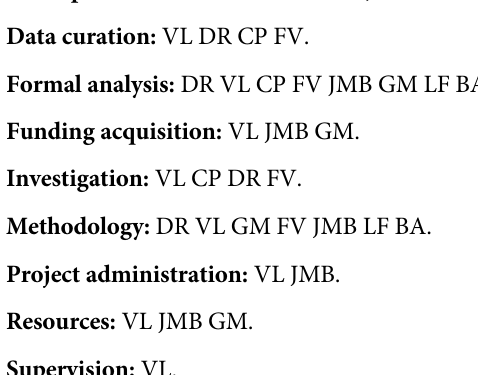
S2 Fig. Figure illustrating lungs histology after secondary infection. Methods: Histologic analysis of hematoxylin and eosin (H&E)-stained lung specimens was performed to confirm the presence of pneumonia 48h and 7 days after intra-tracheal administration of P. aeruginosa (2.107 CFU). Briefly, lungs were removed and fixed by intra- tracheal infusion of paraformal- dehyde (4%). They were kept in 4% paraformaldehyde at least 36h, dehydrated in successive bath with respectively 30, 50 and 70% of ethanol, embedded in paraffin, cut into 8 μ m-sections and stained with H&E. Results: Two days after Pseudomonas administration both CLP and Sham mice exhibited pneumonia as we observed intra-alveolar hemorrhage and massive inflammation, as extensive polymorphonuclear and mononuclear cell infiltration in both groups. Seven days after intra-trachal administration, alveolar infiltration diminished more in Sham operated mice than in CLP